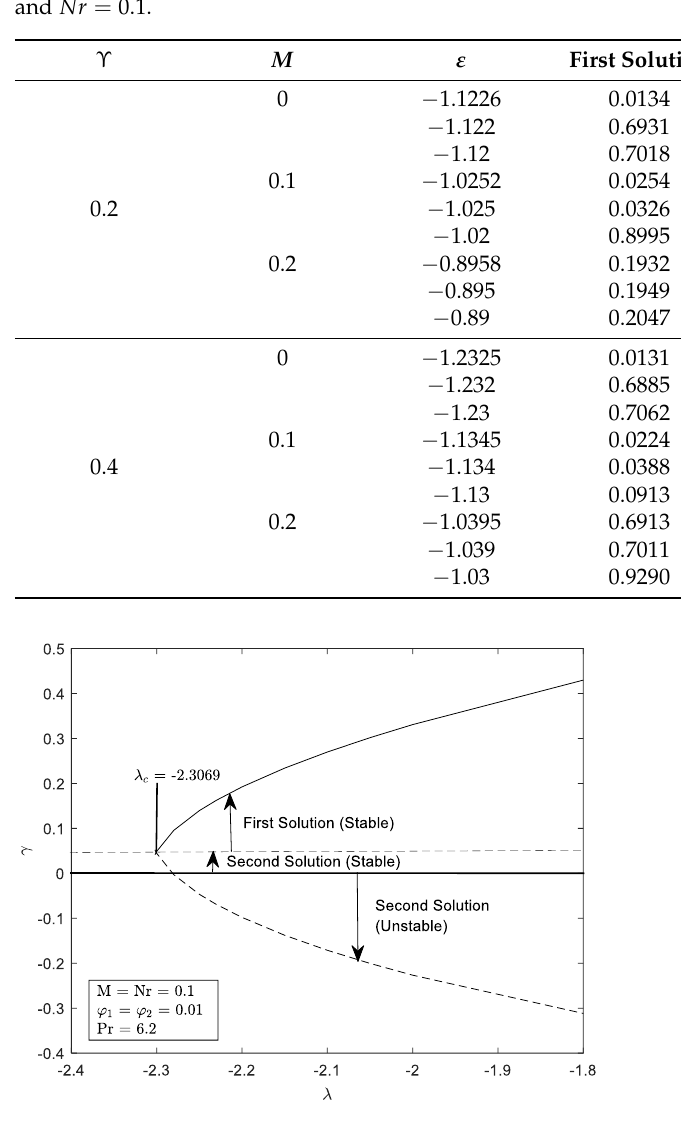
Figure 27. Minimum eigenvalues 𝛾 for selected values of 𝜆 .